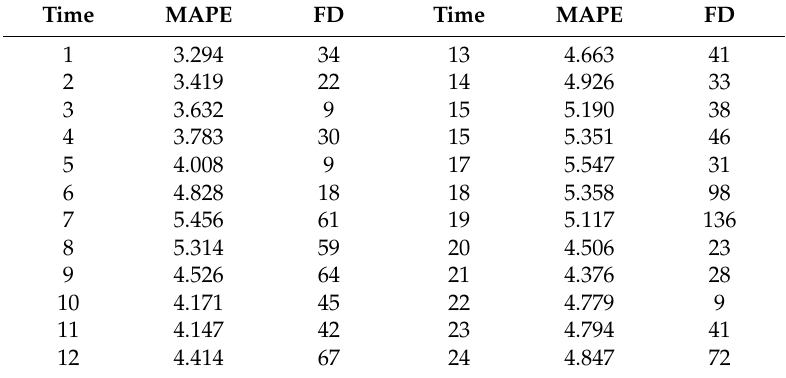
Table 4. Optimal feature subset construction of different hours with mutual information (MI) + random forest (RF) for New England.